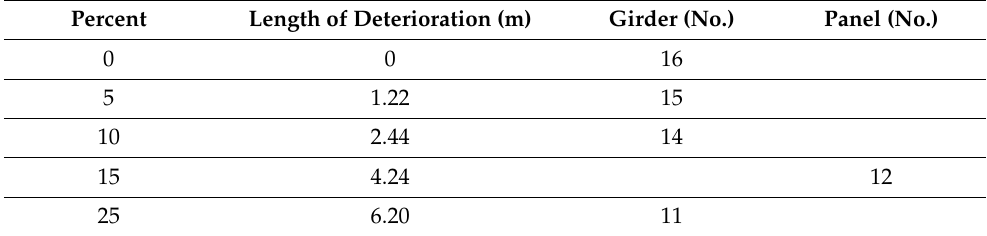
Table 2. Horizontal paths deterioration. Percent Length of Deterioration (m) Girder (No.) Panel